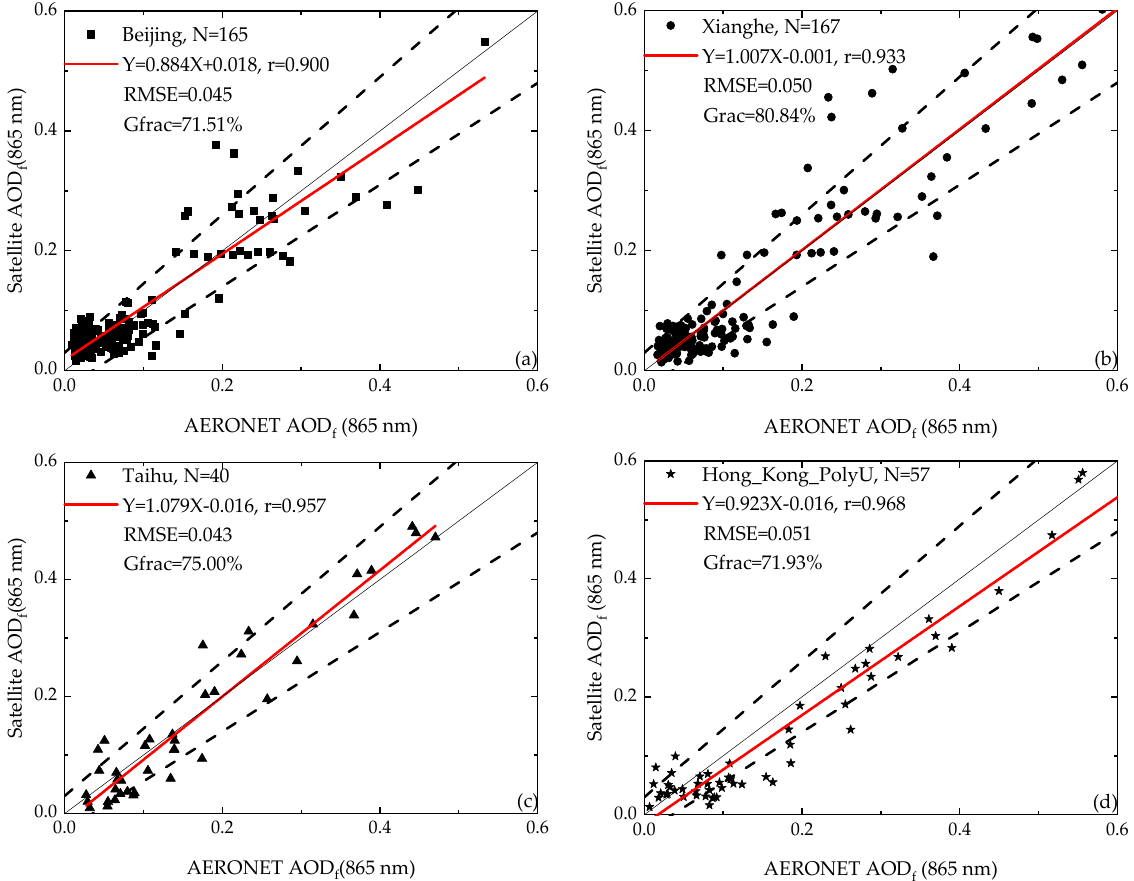
Figure 6. The AOD f validation results of the Beijing ( a ), Xianghe ( b ), Taihu ( c ) and Hong_Kong_PolyU sites ( d